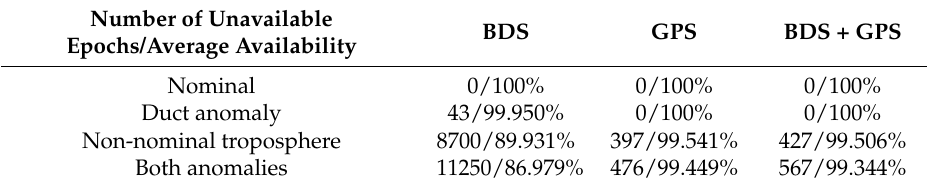
Table 3. Average availability results under tropospheric anomalies for 10 days (86,400